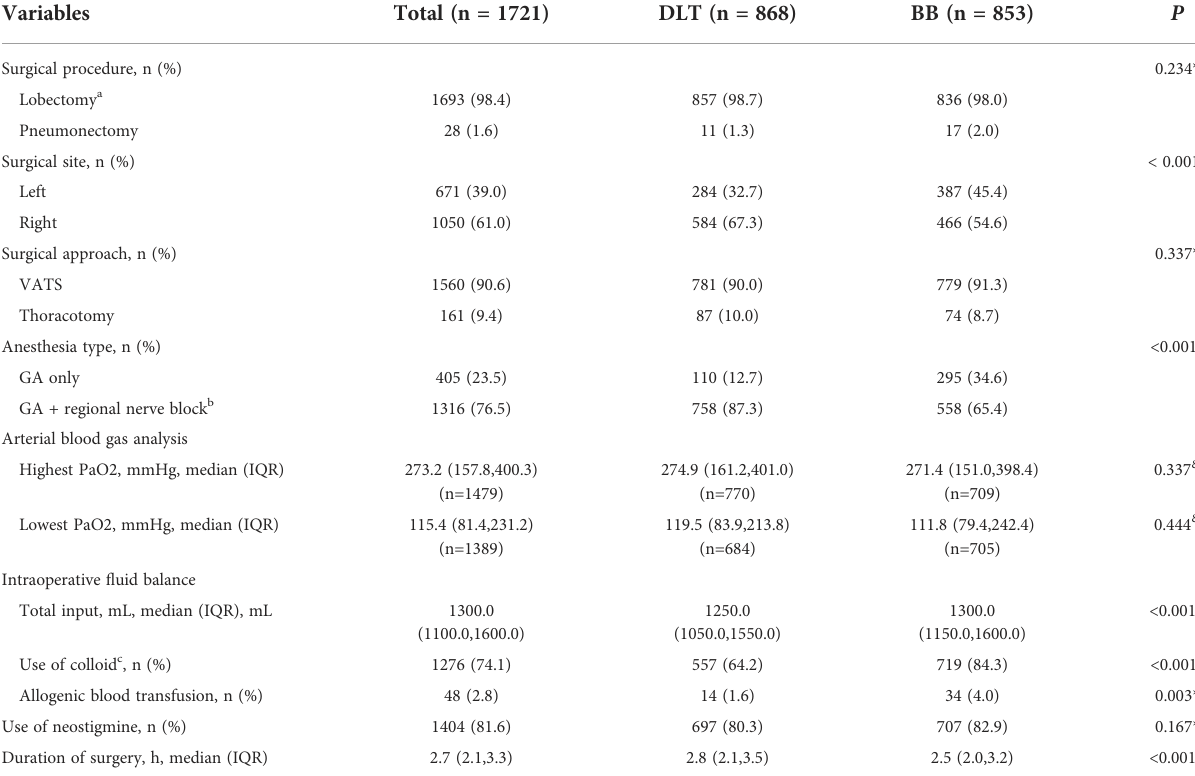
TABLE 2 Intraoperative